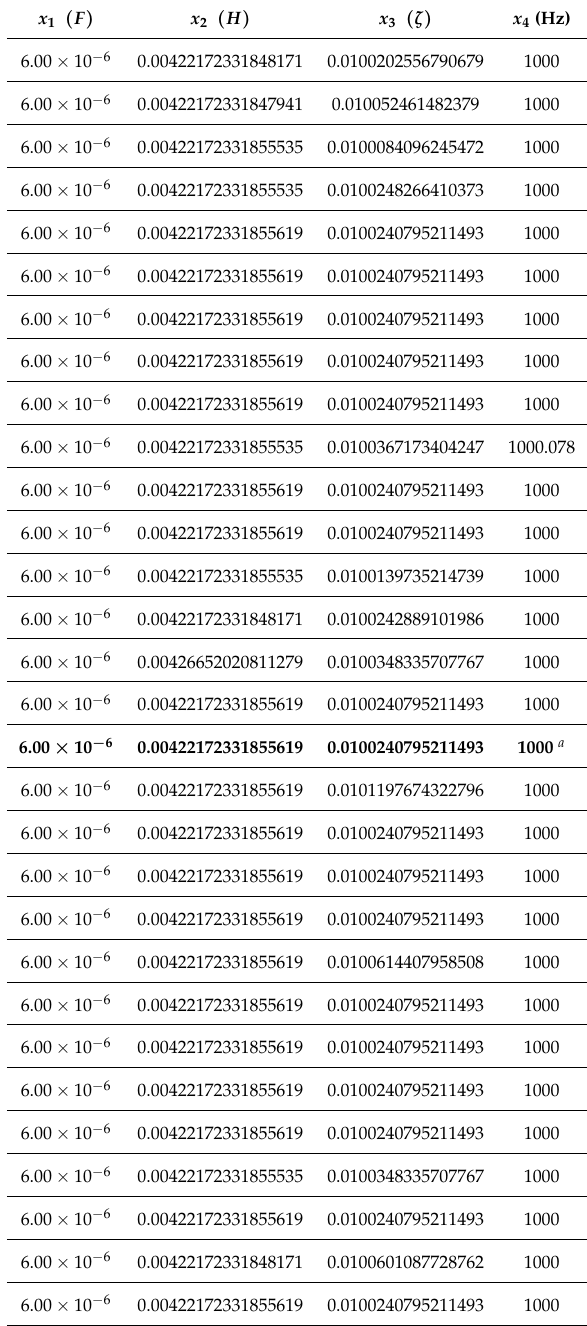
Table 3. The 30 best individuals for the output filter